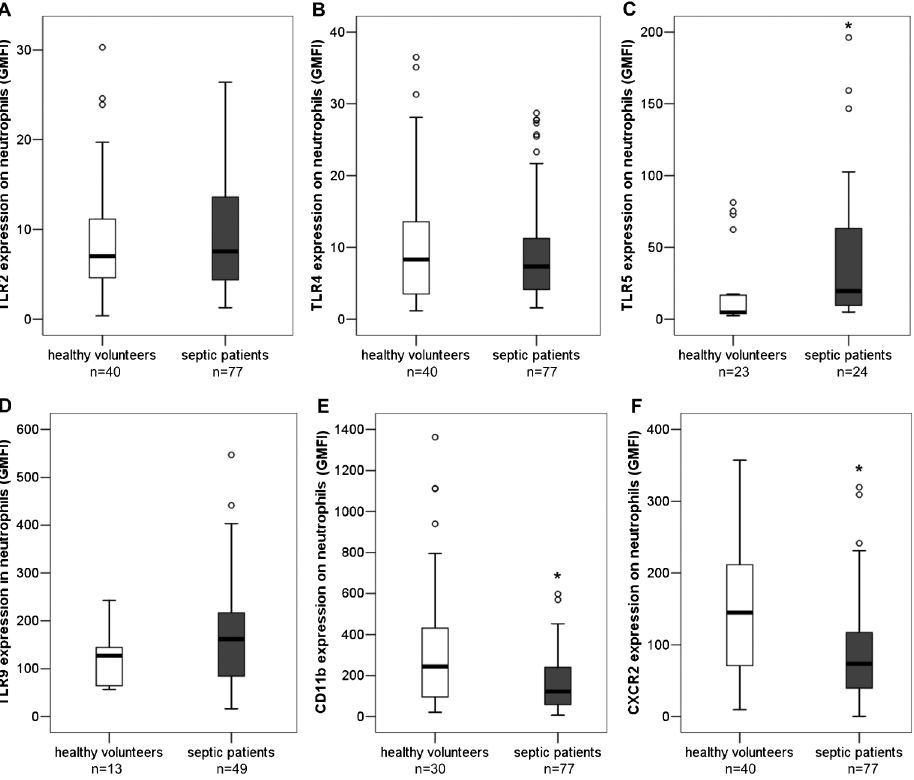
Figure 2. Analysis of the expression of surface and intracellular receptors on neutrophils from healthy volunteers and septic patients. Receptor expression was analyzed in histograms and reported as the geometric mean fluorescence intensity (GMFI): TLR2 ( A ), TLR4 ( B ), TLR5 ( C ), TLR9 ( D ), CD11b ( E ), and CXCR2 ( F ). Data are reported as box plots, medians with 25 to 75% quartiles (box) and mini- mum and maximum values (bars). Empty circles indicate outliers. *P , 0.05 compared to healthy volunteers (Mann-Whitney